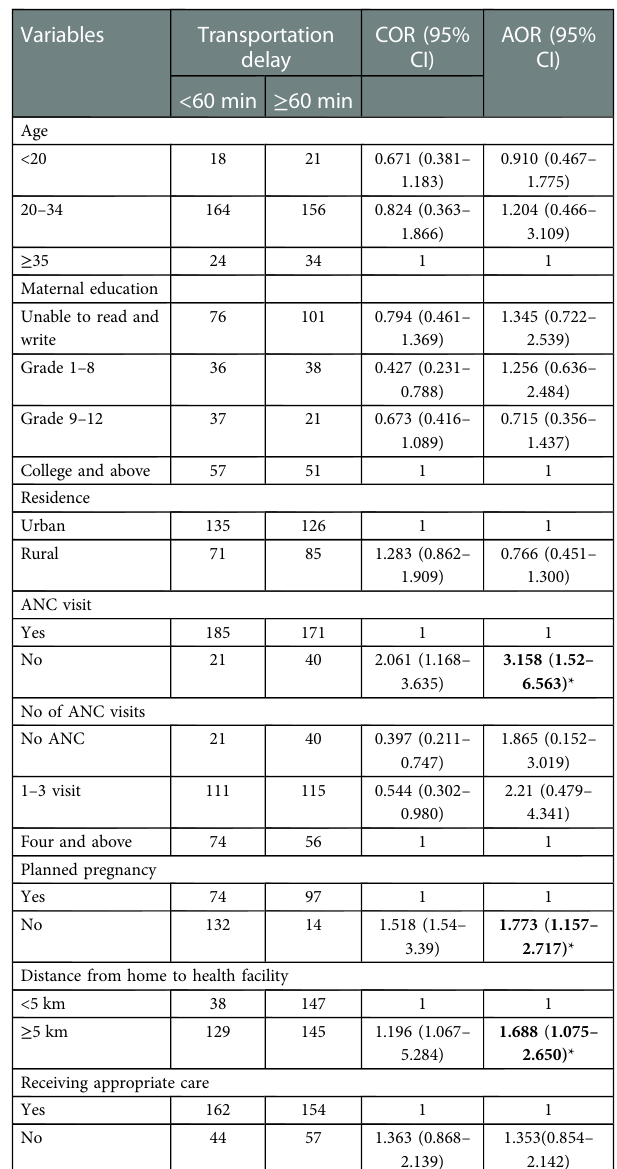
TABLE 4 Factors associated with delay in reaching health facility to institutional delivery of mothers who gave birth in South Gondar zone hospitals, Northwest Ethiopia,